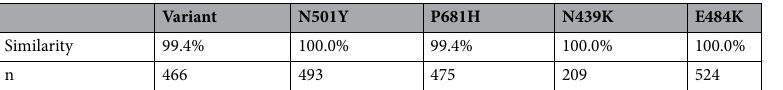
(Table 5). 32.8% of the samples were inconclusive in either the mutation assay and/or Sanger sequencing. This might be due to the higher sensitivity of the CoviDetect™ and CoviDetect™ Fast assays with LOD of 20 and 5 copies respectively, making them able to detect smaller amounts of SARS-CoV-2 RNA. In Table 9 the samples lineage are determined for results with both valid PCR results and valid Sequencing data. The determination of